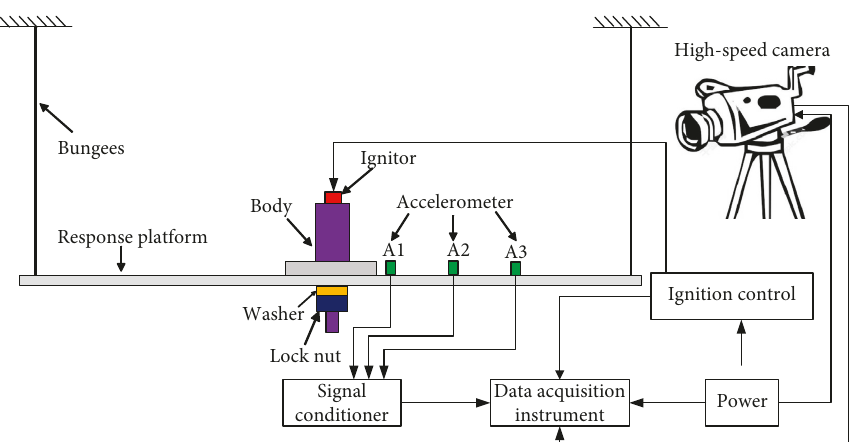
Figure 3: Diagram of separation characteristic test setup.